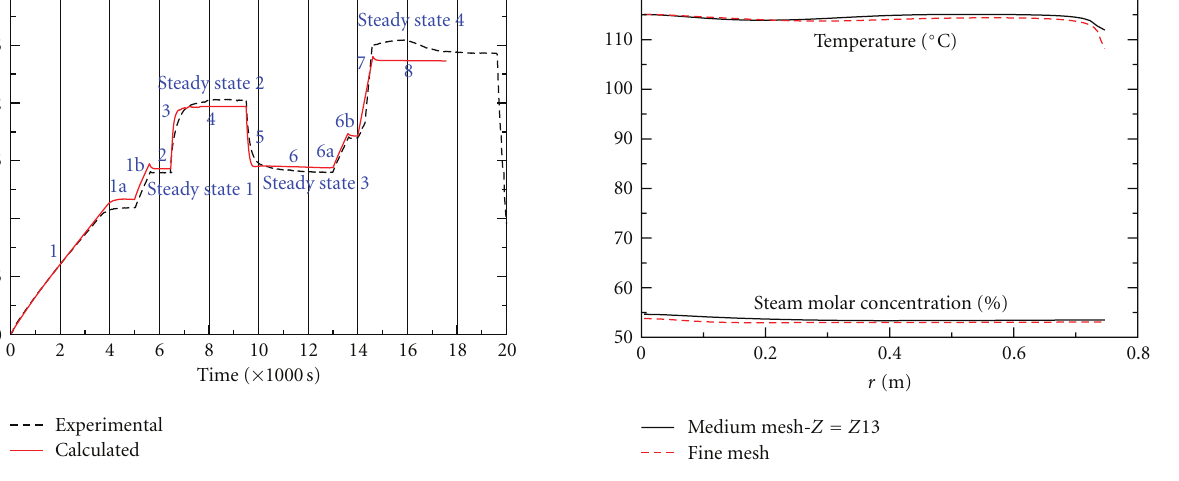
Figure 5: Radial profile of the steam molar concentration and temperature at Z 13 = 3 . 93 m at time = 3900 s: grid convergence.